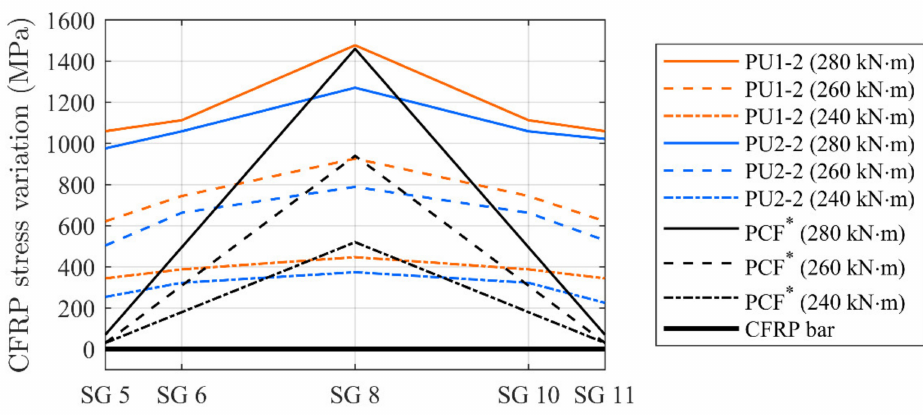
Figure 14. Measured stress transfer at different moment magnitudes.